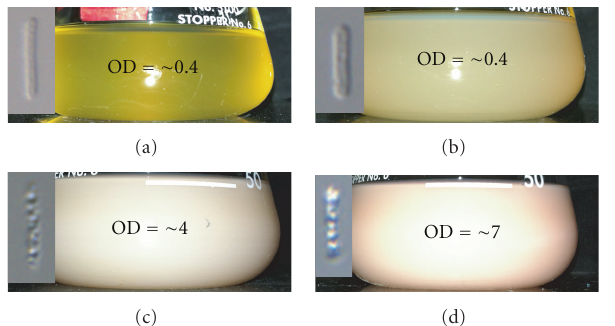
Figure 6: Cell and culture phenotypes under slow shaking condi- tions. Halobacterium salinarum NRC-1 cells were grown at 100 rpm as described in Materials and Methods. Phenotypes were tracked in slow shaken growth conditions by the culture vessel and by visible light microscopy of individual cells. Cell images are representative of > 95% of the cultures’ cell morphology at a specific time point. Time points were taken from Figure 5. (a) Culture and cell images from before the growth plateau, OD 600 =∼ 0 . 4. (b) Culture and cell images from after the growth plateau, OD 600 =∼ 0 . 4. (c) Culture and cell images from mid-stationary phase, OD 600 =∼ 4 . 0. (d) Culture and cell images from late stationary phase, OD 600 =∼ 7 . 0.